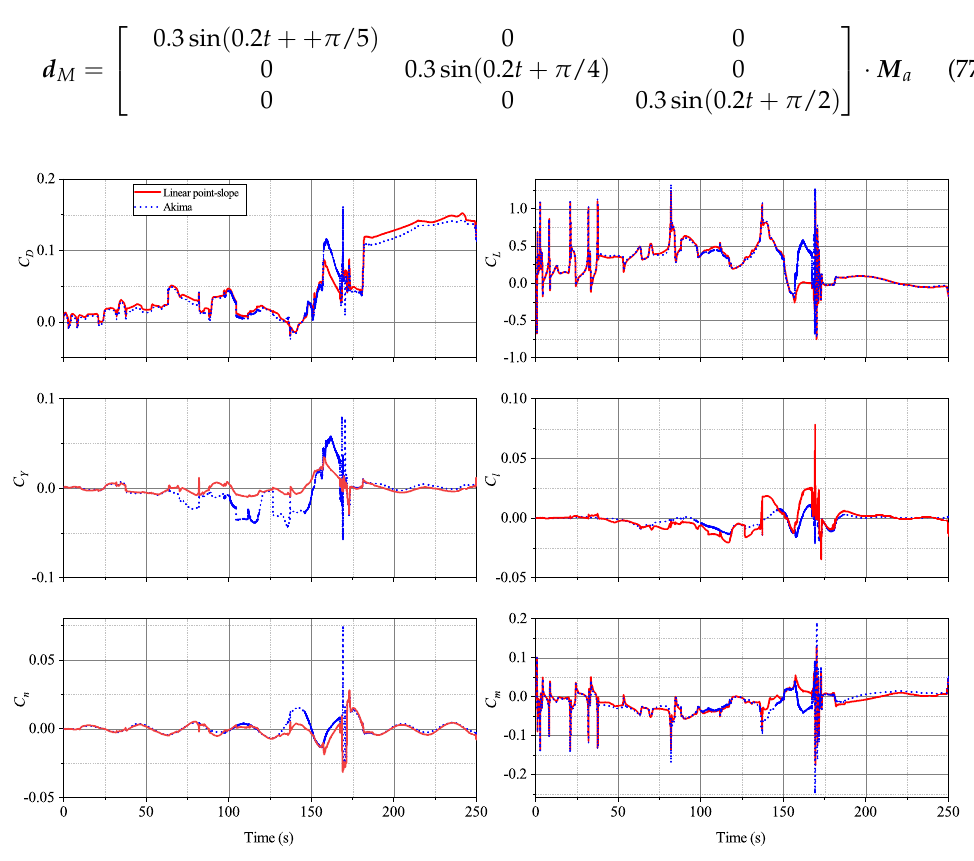
Figure 4. Aerodynamic coefficients.